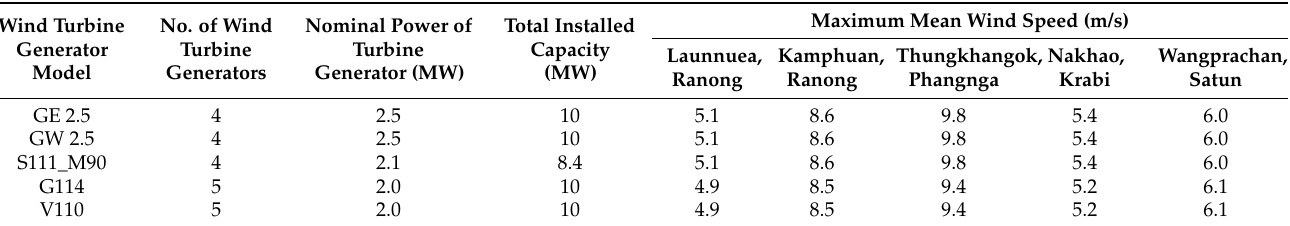
Table 5. Details of the WTG, total installed capacities and maximum mean wind speeds for the five potential sites for wind power